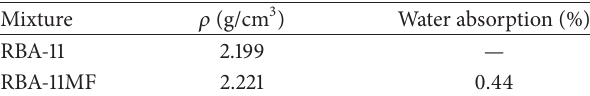
Table 7: Physical properties.